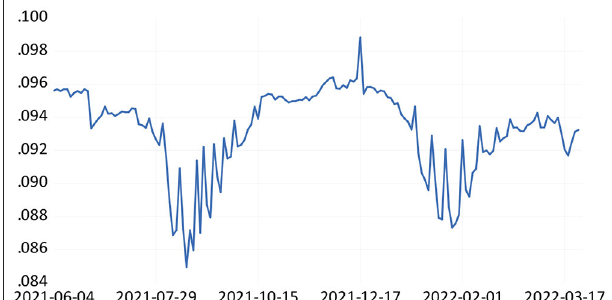
FIGURE 1 | MADEUR exchange rate